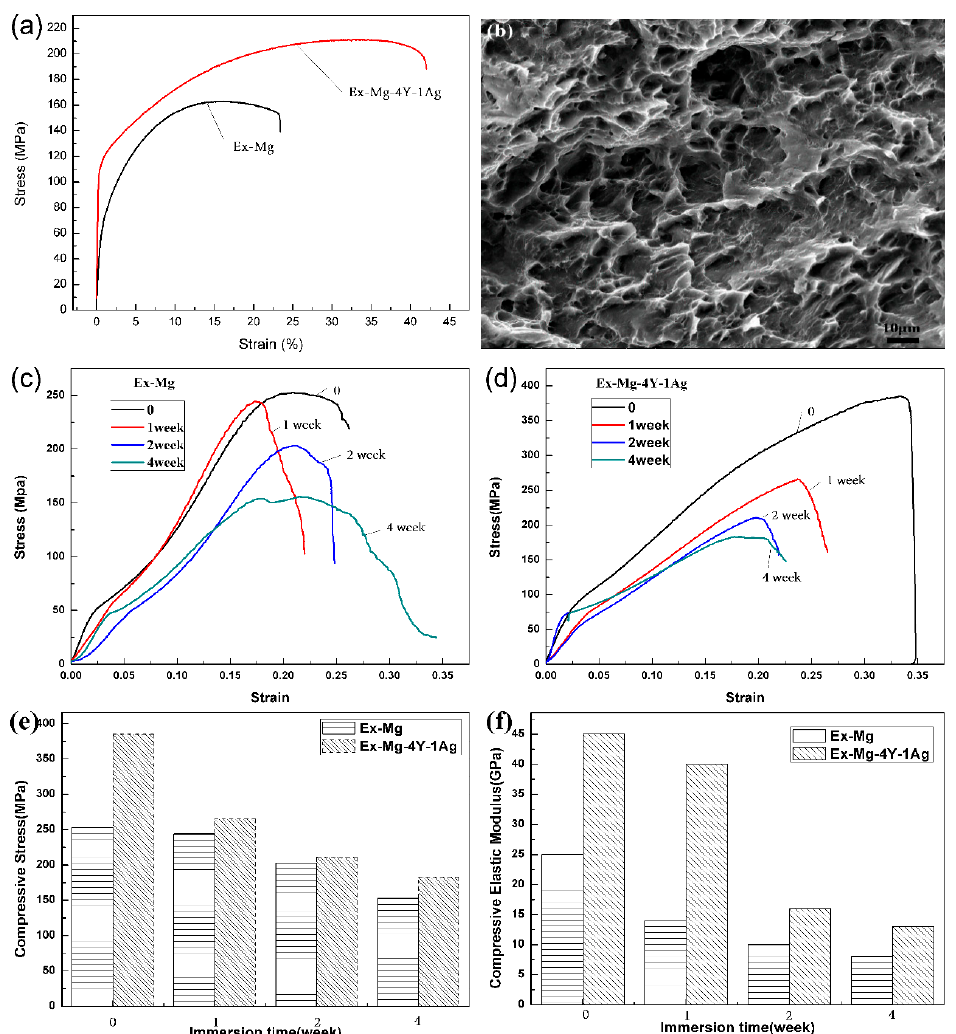
Figure 2. ( a ) Stress ‐ strain tensile curves of Ex ‐ Mg and Ex ‐ Mg ‐ 4Y ‐ 1Ag; ( b ) fracture morphology of Ex ‐ Mg ‐ 4Y ‐ 1Ag; Stress ‐ strain compressive curves of samples after different immersion time: ( c ) Ex ‐ Mg ‐ 4Y ‐ 1Ag, ( d ) Ex ‐ Mg, ( e ) ultimate compressive strength ‐ week graph of Ex ‐ Mg and Ex ‐ Mg ‐ 4Y ‐ 1Ag; and ( f ) compressive elastic modulus ‐ week graph of Ex ‐ Mg and Ex ‐ Mg ‐ 4Y ‐ 1Ag.